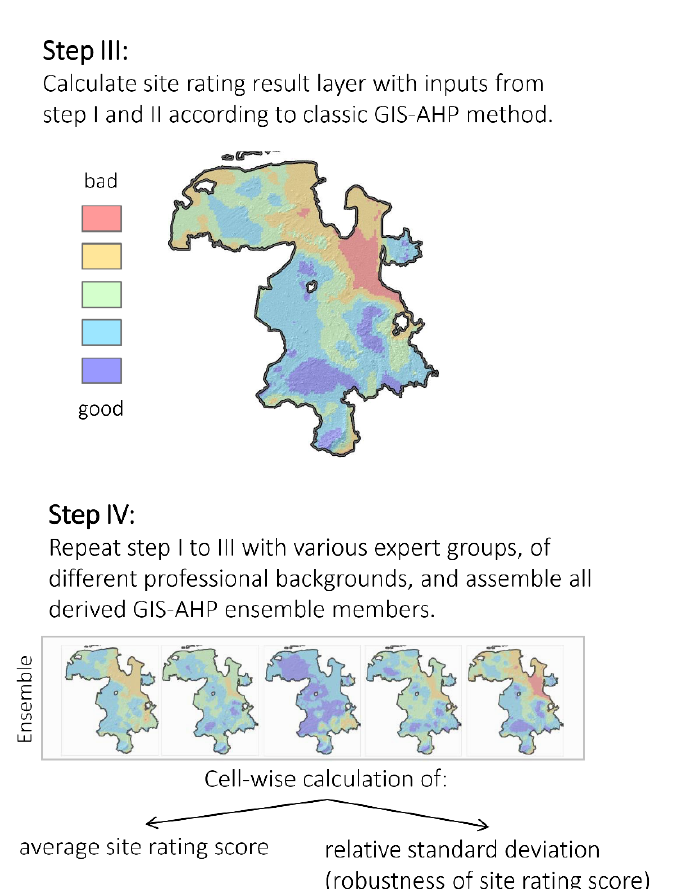
Figure 2. Flow chart of the GIS-AHP ensemble methodology; steps I to III represent the procedure for executing the classic GIS-AHP and step IV represents its extension to the here proposed GIS-AHP ensemble methodology.